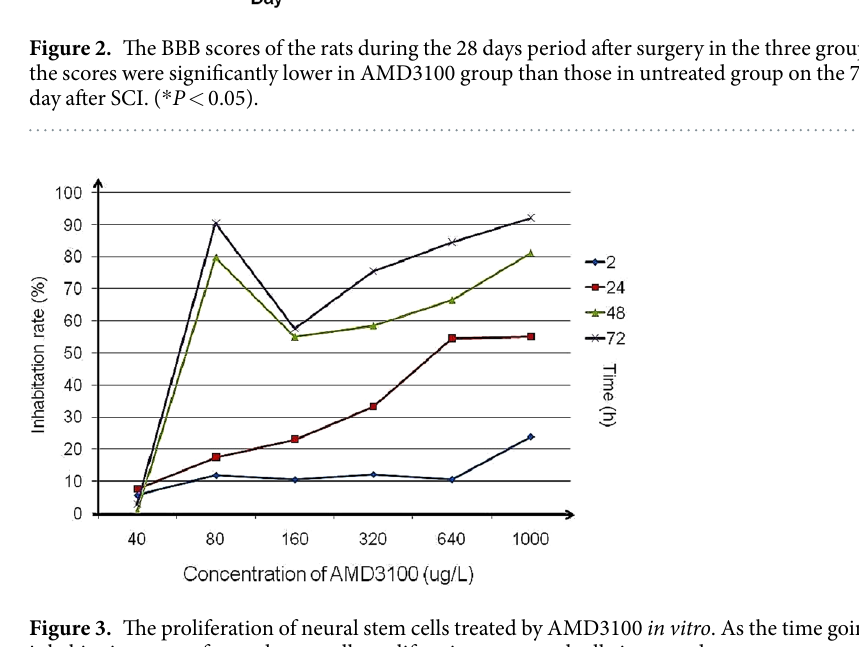
Figure 3. The proliferation of neural stem cells treated by AMD3100 in vitro . As the time going on, the inhabitation rates of neural stem cells proliferation were gradually